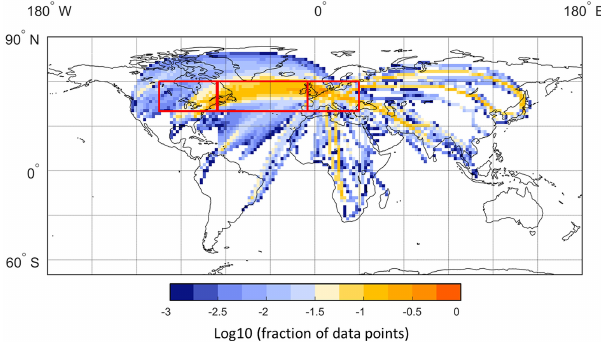
Figure 1. Global coverage of water vapour observations by MOZAIC for the period 1995 to 2010 shown as decadal logarithm of the fraction of measurements in a certain grid box. Red boxes indicate the target areas for our